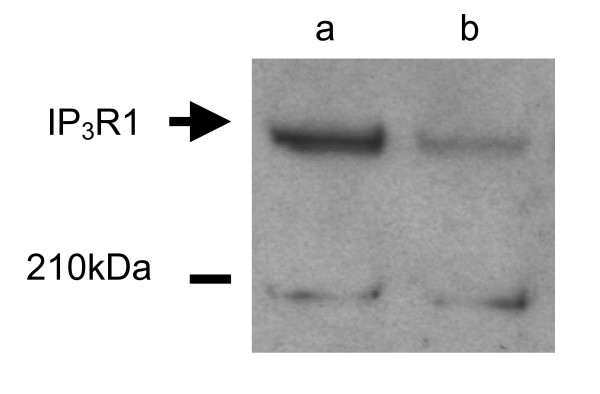
Western blot analysis of IP3 receptor in mouse oocytes which matured in vitro, and were fertilised during maturation, and in in vitro matured oocytes, which were not fertilised. (a) in vitro matured oocytes in MII stage, 100 oocytes per lane, (b) oocytes fertilized during in vitro maturation, which achieved MII stage, 100 oocytes per lane.